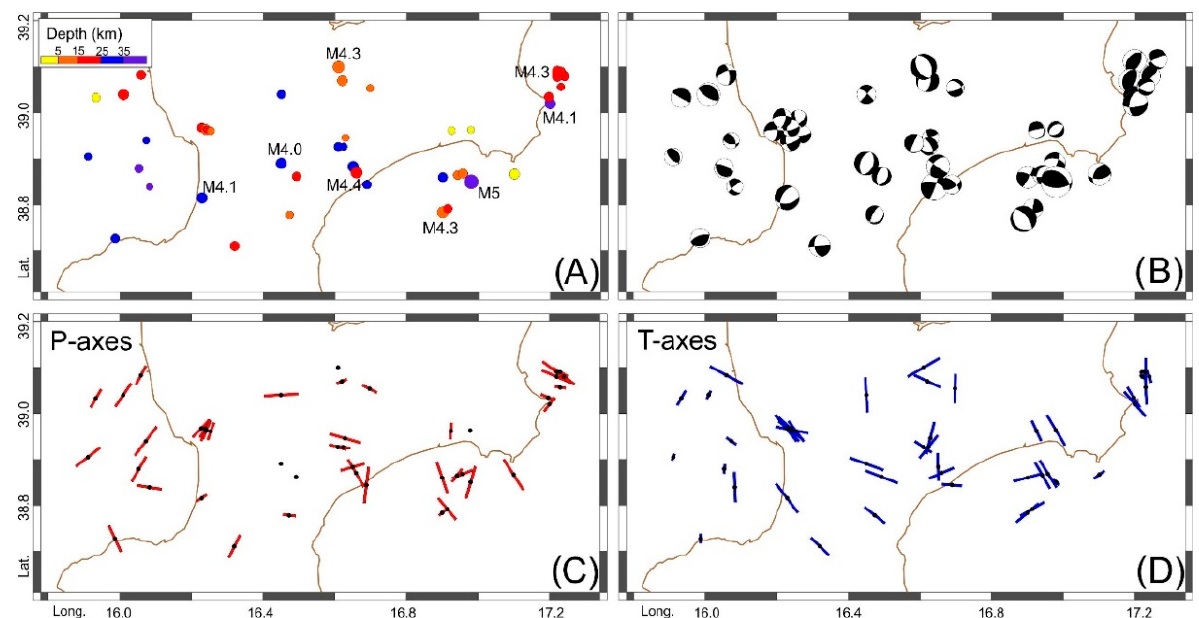
Figure 6. Earthquakes distribution available in the literature (see text); ( A ) Distribution in depth; ( B ) focal solutions; ( C ) P ‐ axes distribution; ( D ) T ‐ axes distribution.